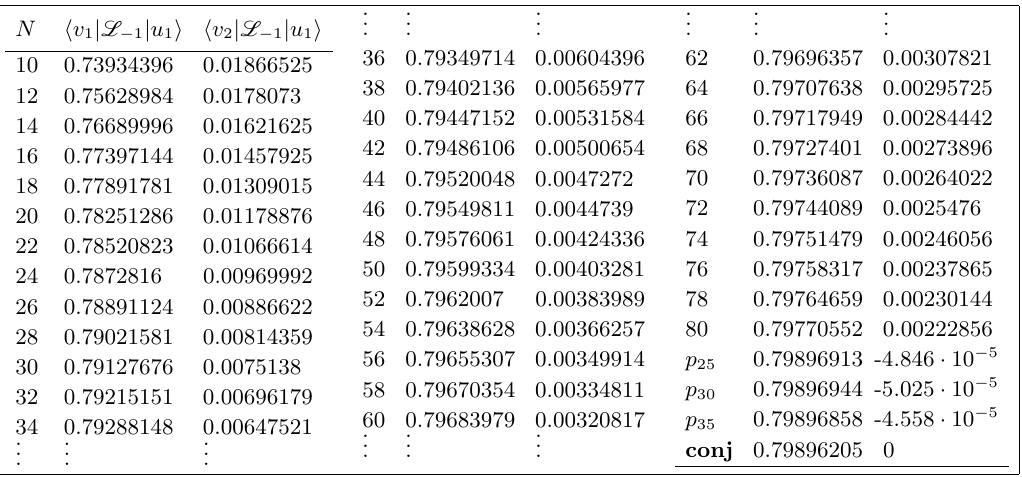
Table 1 . Matrix elements ( L (cid:0) 1 [ N ]) v for i = 1 ; j = 1 and i = 2 ; j = 1, where the scaling states i u j j u j i and j v i i follow the patterns of Bethe integers shown in (5.4) and (5.5). The numerical values are given for the case of S z = 1 ; e = 0 ; x = (cid:25); (cid:30) = 1 = 10 for system size N up to 80, after which polynomial extrapolations p n (1 =N ) of degrees n = 25 ; 30 ; 35 to all the data points are made in order to approximate the value at N ! 1